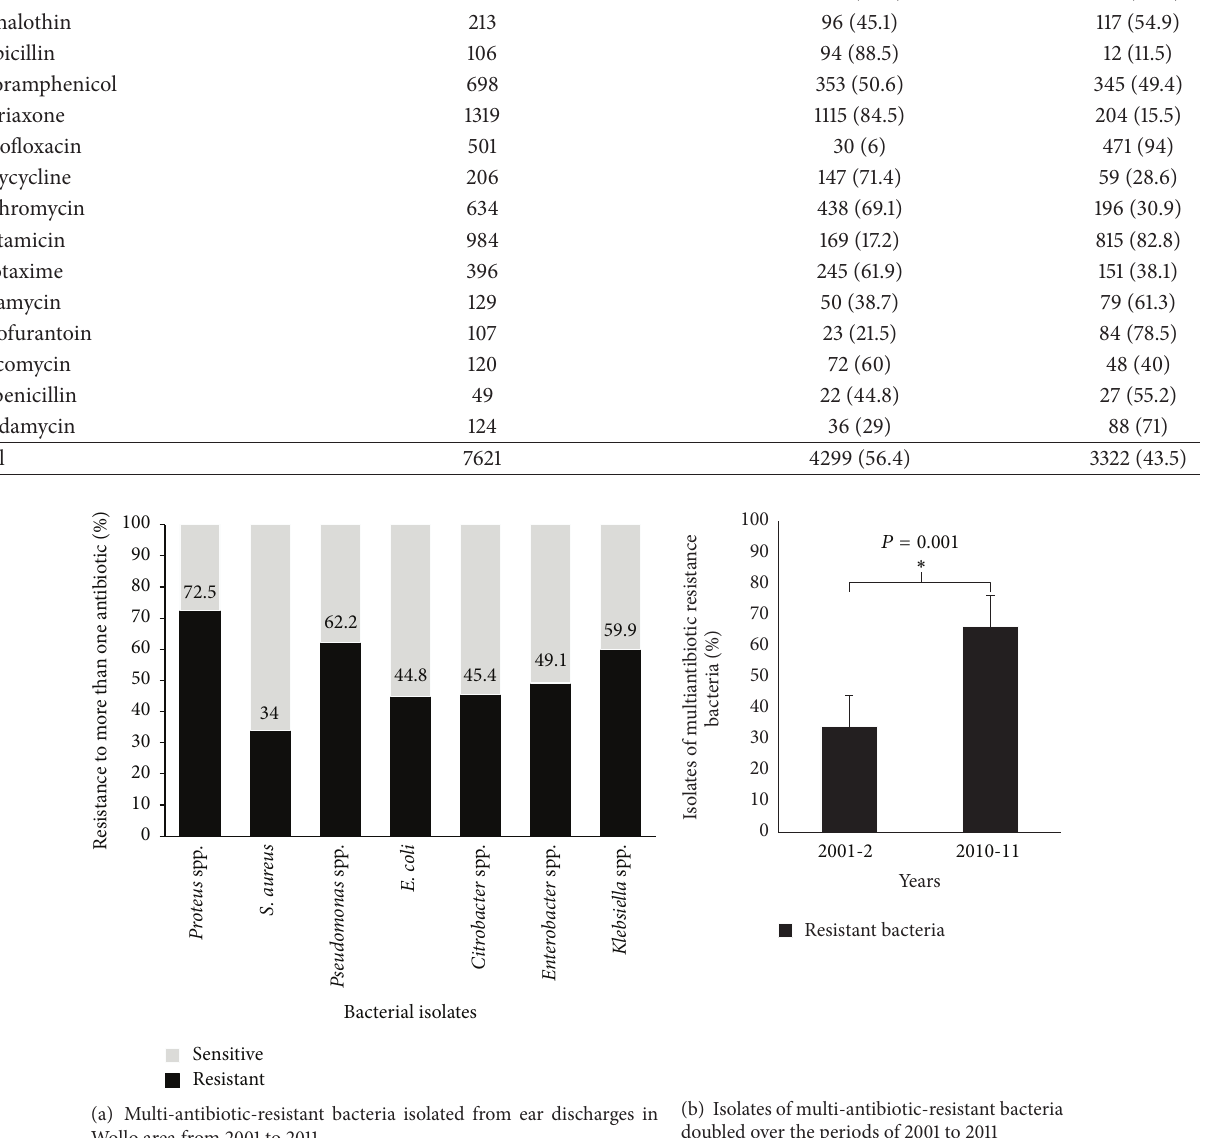
Figure 1: Rates of multi-antibiotic-resistant pathogenic bacteria isolated from patients suspected of having otitis